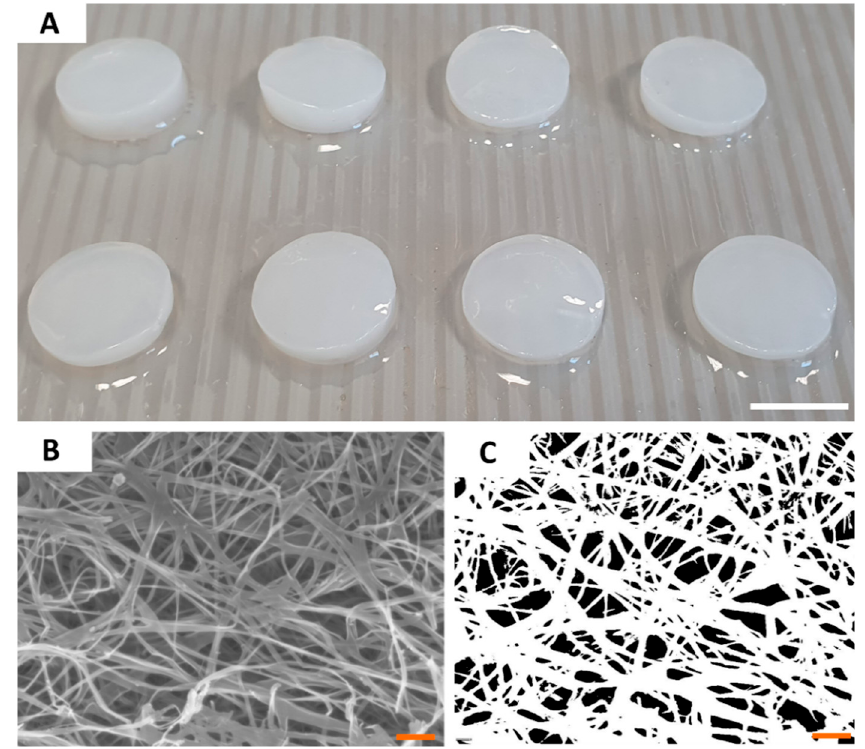
Figure 2. The macroscopic ( A ) and microscopic ( B , C ) pictures of BC carriers. The picture ( B ) was taken using SEM Auriga 60 microscope under magnification equal 50,000×; and subjected to re-processing ( C ) which allowed to calculate the porosity of carrier surface. Scale bars are equal to 1 cm in photo ( A ) and 1 µm in photos ( B , C ).